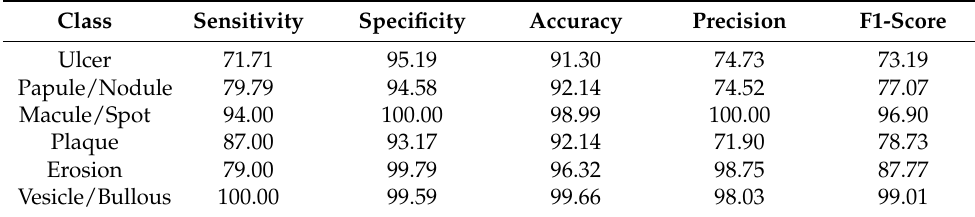
Table 3. Metrics in percentage reported for each of the elementary